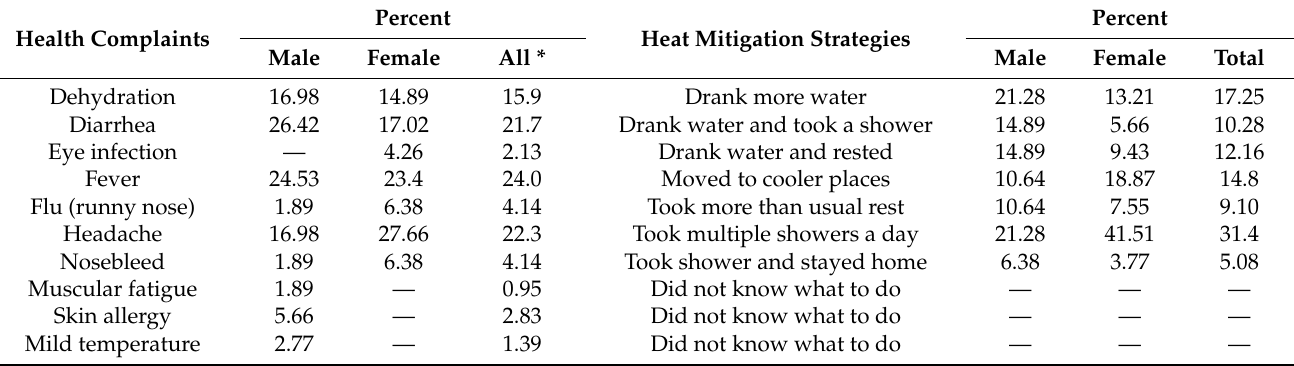
Table 4. Gender-wise ( n = 104 @ 2 samples per household) data for heat-related health complaints and heat mitigation strategies adopted by the